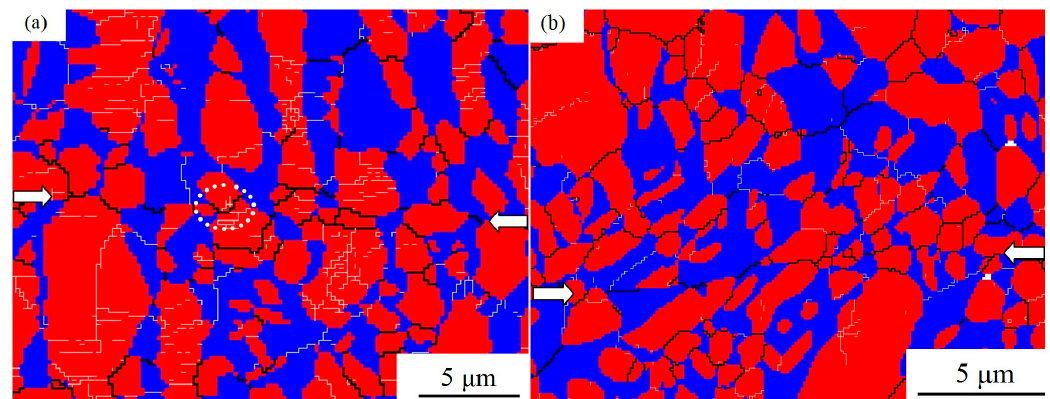
Figure 8. EBSD orientation maps of Ti–5Al–2Sn–2Zr–4Mo–4Cr alloy bonds obtained at different times: ( a ) 1 min; ( b ) 10 min.